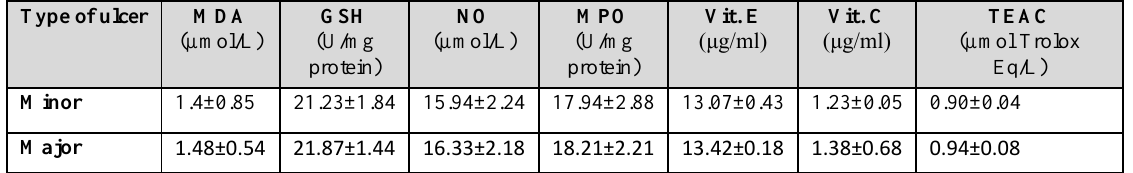
Table (3): Plasma values of tested parameters to the type of recurrent aphthous